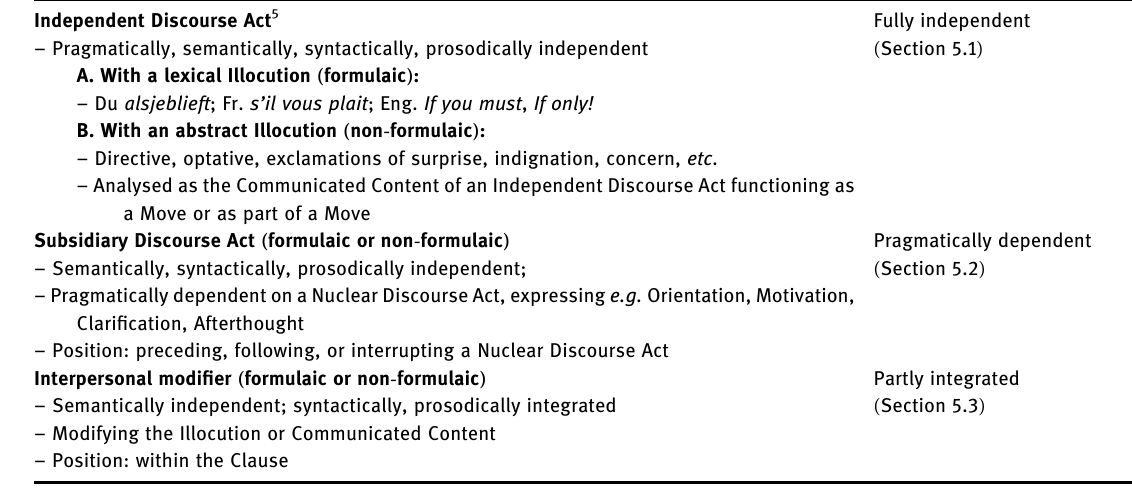
Table 1: Overview of non - canonical if - clause categories Independent Discourse Act